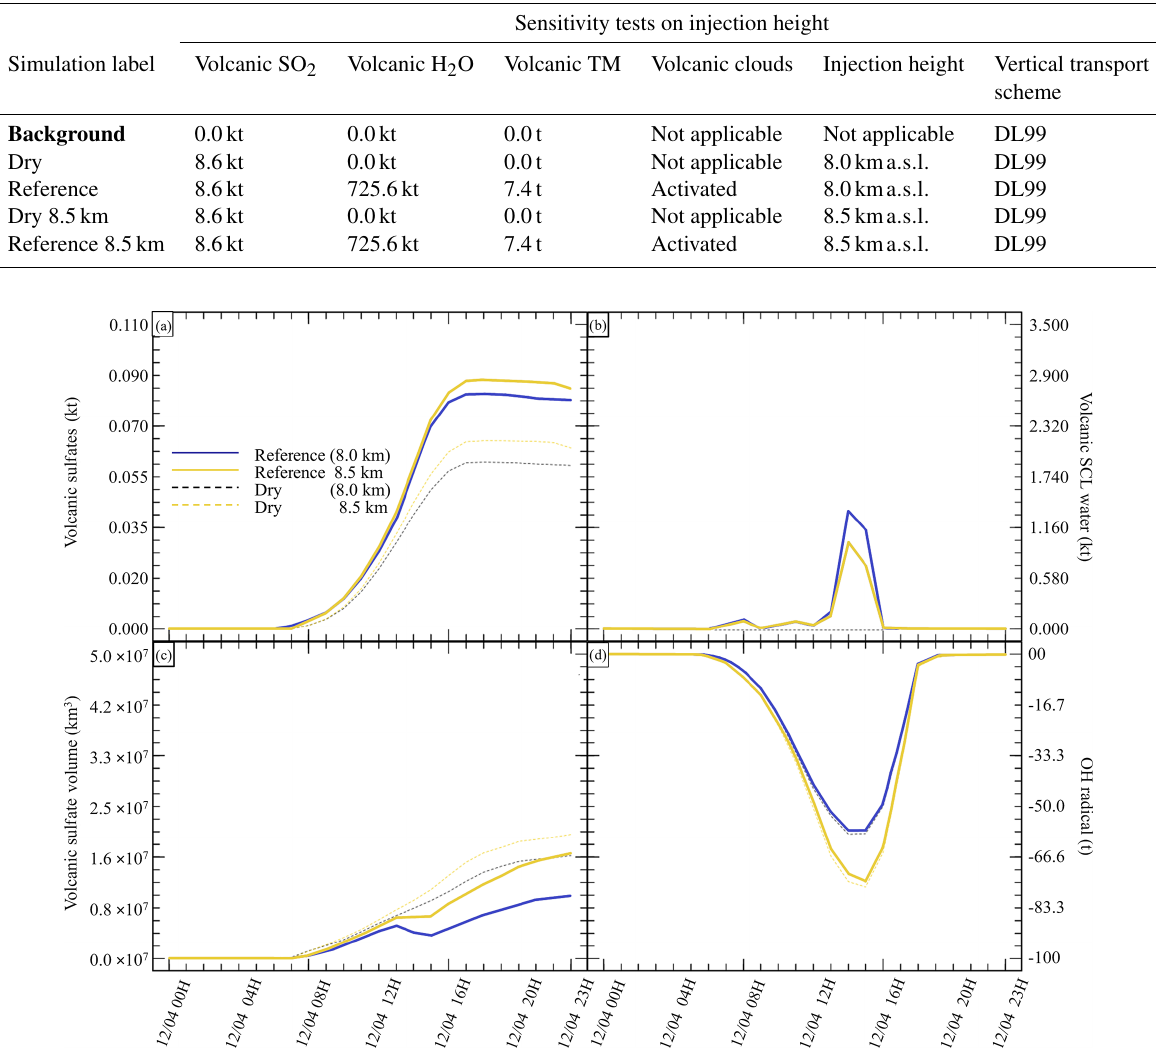
Table 4. Simulation parameters for sensitivity tests on injection height. Bold items indicate background simulations that are used to retrieve background values. “Volcanic TM” stands for “volcanic transition metals”.